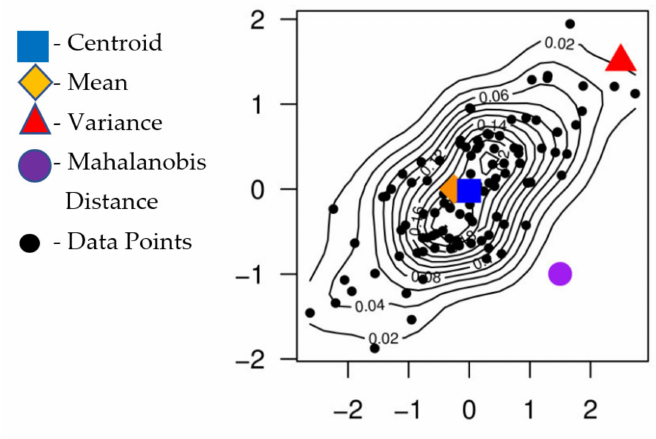
Figure 1. Illustration of the Mahalanobis distance in a bivariate space adapted from [9]; the contours represent the behavior of the MD in the bivariate space. The Mahalanobis distance can detect outliers in the bivariate